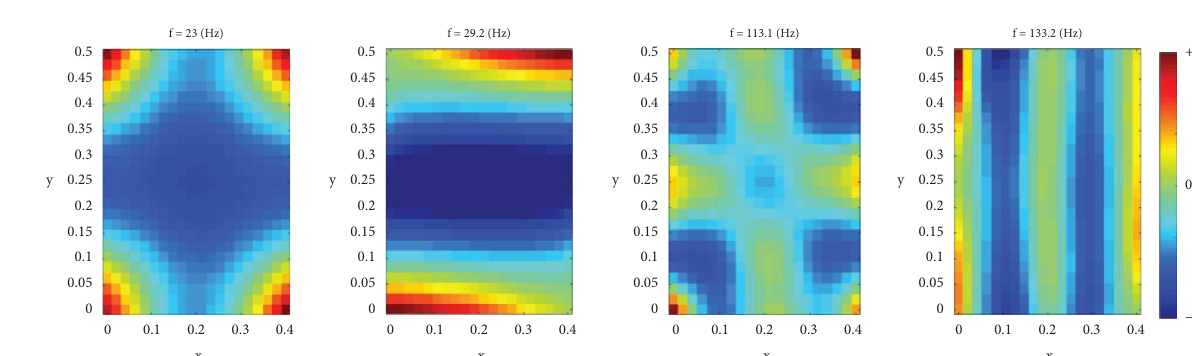
Figure 9: FRF changes by local thickening at four chosen